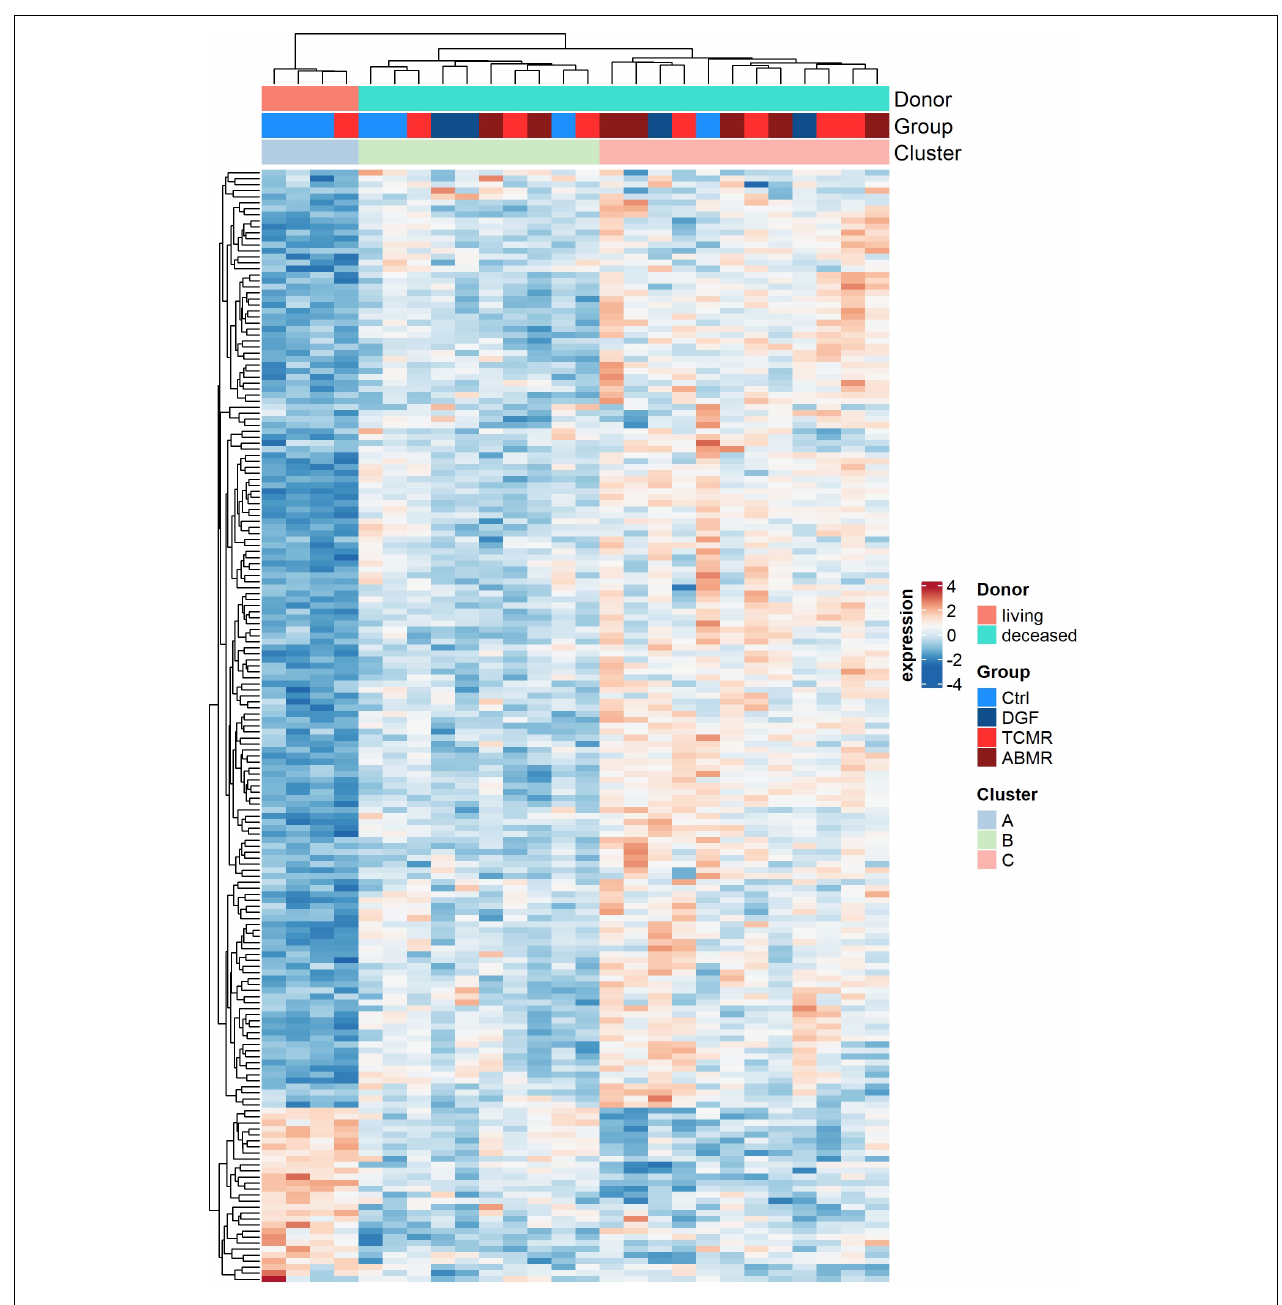
FIGURE 2 | Expression heatmap. Expression heatmap of the 185 genes of the NanoString Human Organ Transplant Panel differentially expressed (adjusted p < 0.05) between zero-time biopsies of living (light red) and deceased (turquoise) donors. Two additional color-coded bars on top show sample outcome and membership into three identified clusters. In the heatmap red denotes upregulated genes and blue downregulated genes.